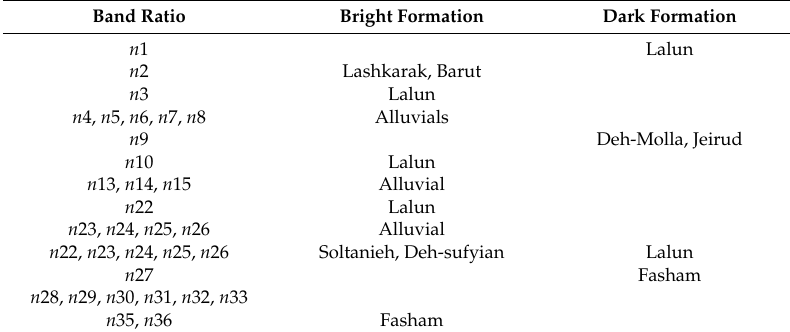
Table 6. BR bands with a specific manifestation (dark or bright pixels) of the sedimentary formations in the study area.